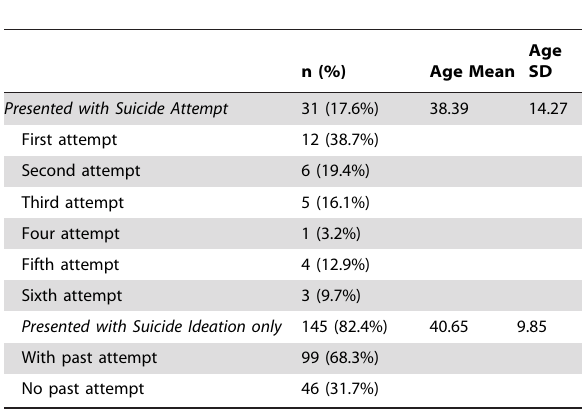
Table 2. Characteristics of Suicide Attempters and Non- Attempters (N =176).